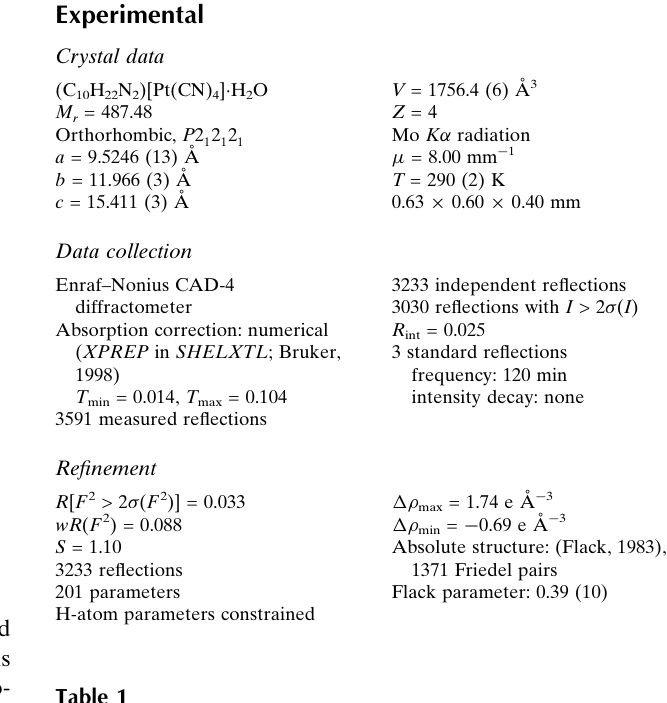
Hydrogen-bond geometry (A˚ , (cid:2)